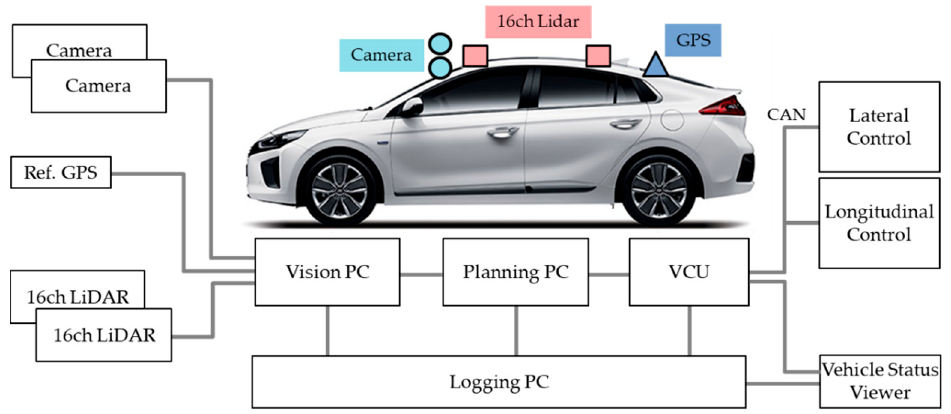
Figure 11. Vehicle hardware configuration.